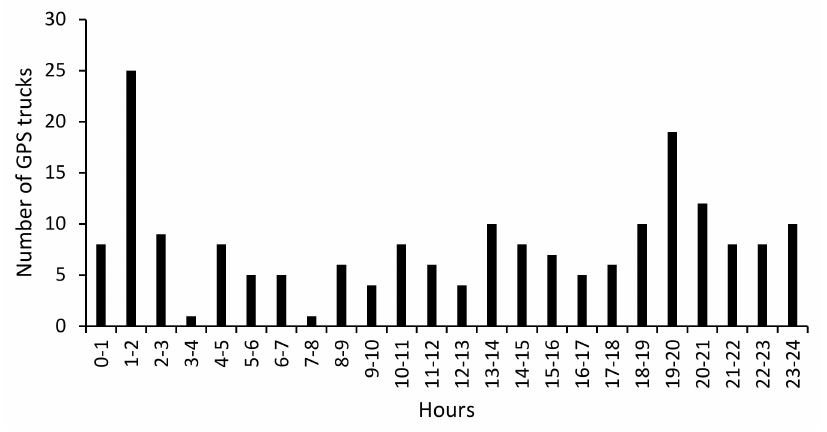
Figure 10. The amount of GPS trucks whose data are available at the system in each hour of 14th February 2019.